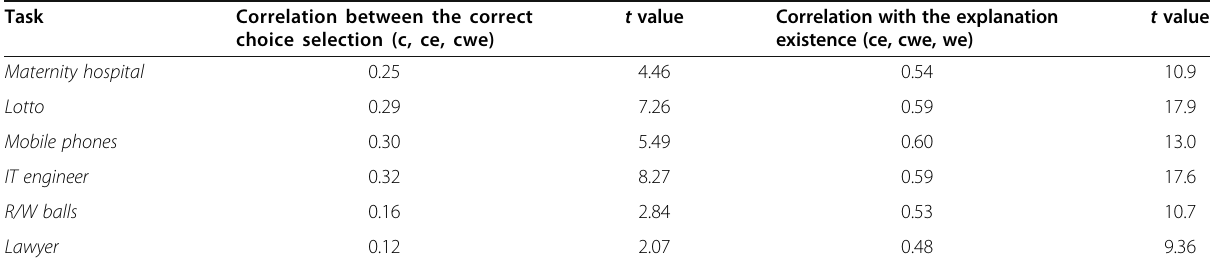
Table 4 Correlation between the correct choice selection and the existence of explanation with the students ’ test-scores Task Correlation between the correct t choice selection (c, ce, cwe)